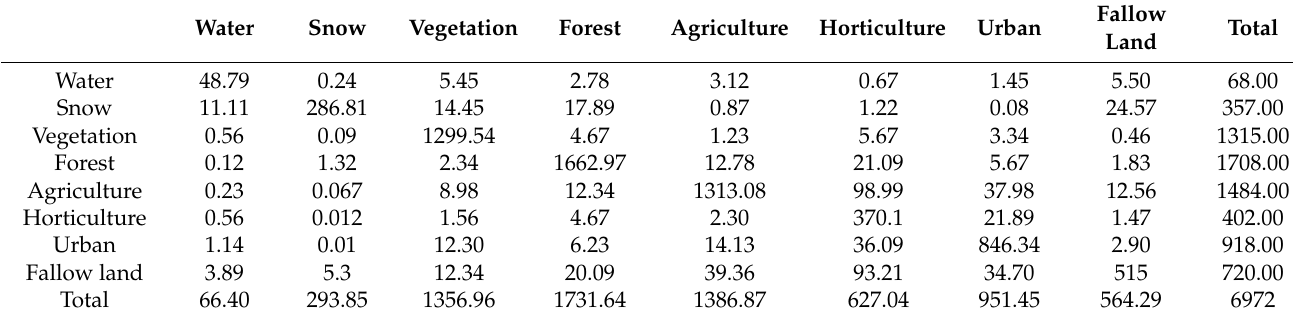
Table 9. Area transfer matrix from 2010–2020 (km 2 ).